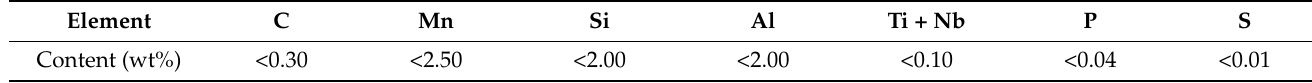
Table 1. Chemical Composition of the TRIP1000 steel